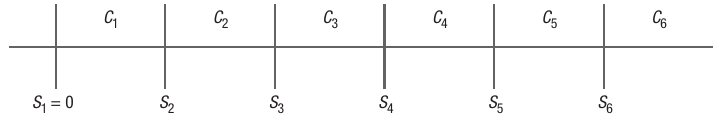
Fig. 5 . Scale of categories of difference of